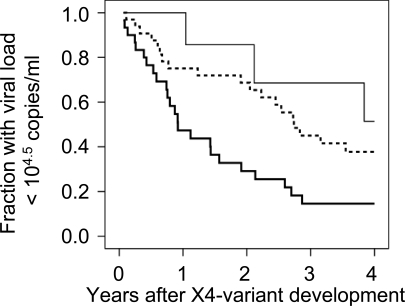
Survival Analysis for R136Q Genotype after Emergence of X4-VariantsKaplan Meier analysis for time in years from the moment of first detection of X4-variants to viral RNA load above 104.5 copies per ml plasma based on the R136Q genotype. Bold black lines indicate individuals with the wild type genotype (136RR); dashed black lines indicate individuals heterozygous for the 136Q genotype (136RQ); thin black lines indicate individuals homozygous for the 136Q genotype (136QQ).